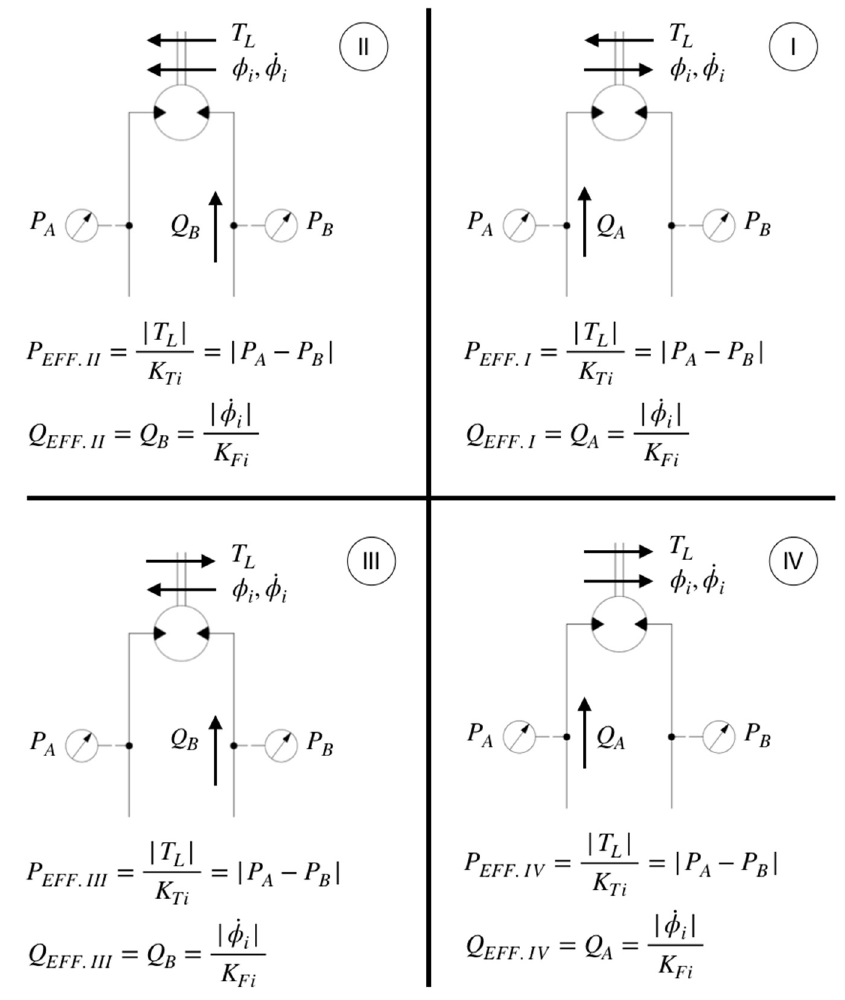
Figure A3. Effective pressure and flow in all quadrants for the tilt actuator.